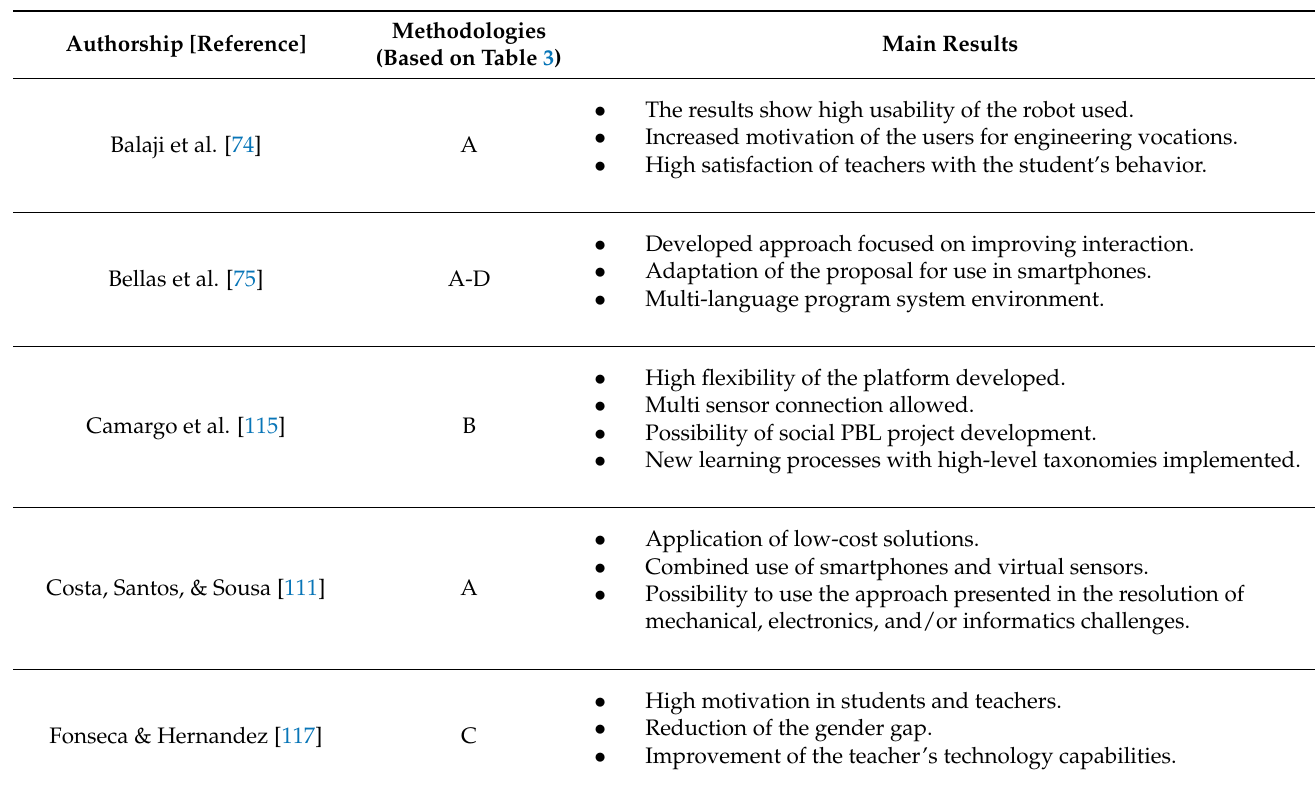
Table 6. Summary of robotics sensors’ teaching-learning methodologies (based on the classification in Table 3) and main results of the papers